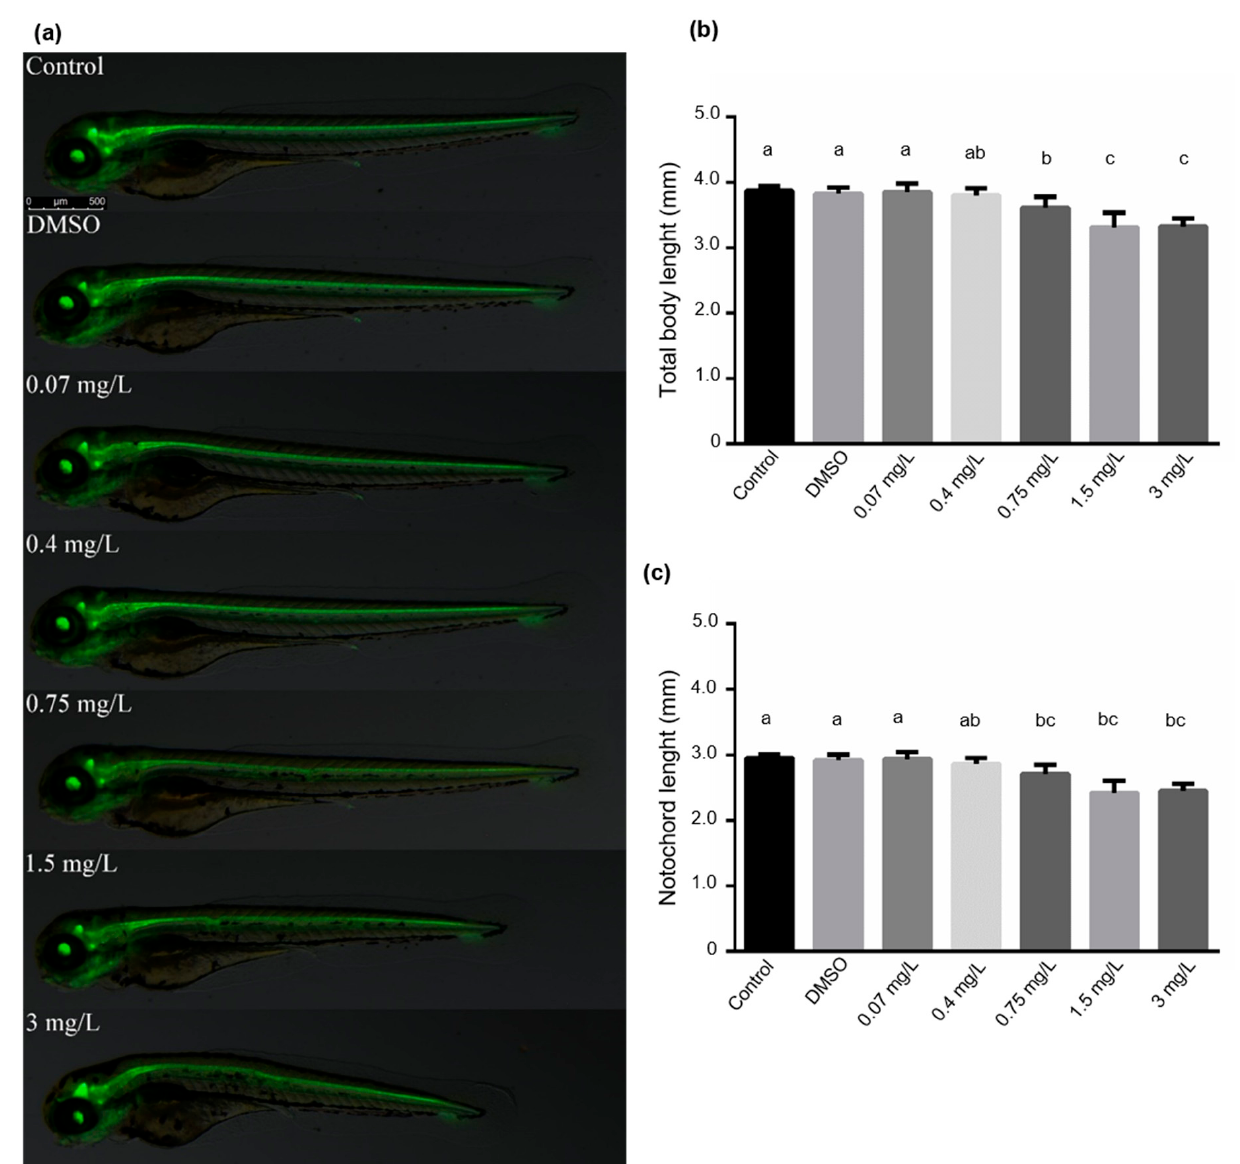
Figure 2. ( a ) Photomicrographs taken at 72 hpf. ( b ) Total body length and ( c ) notochord lengths of zebrafish embryos exposed to various concentrations of bendiocarb during a 96-h test. Data represent the mean ± SD of two repeated tests. Columns superscripted with different letters are significantly different (One-way ANOVA followed by post-hoc Tukey’s test; N = 30; p < 0.05).